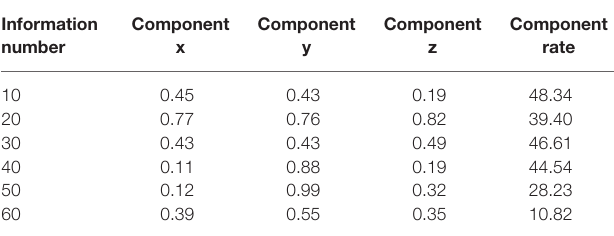
TABLE 1 | Values of independent components of teachers’ teaching